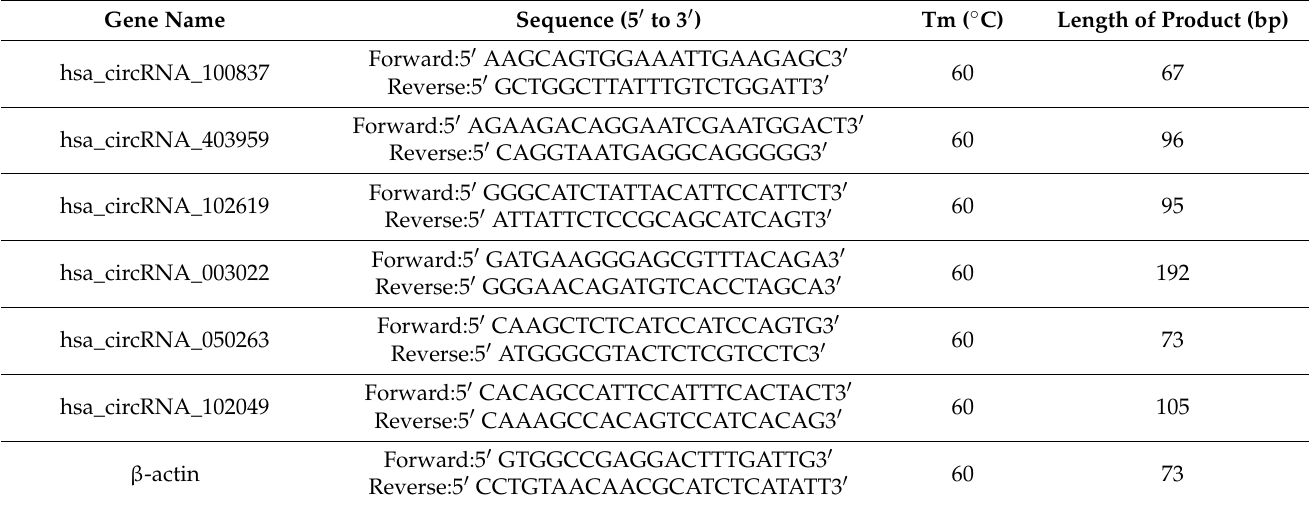
Table 4. PCR primers set (Arraystar Inc.) used for qRT-PCR